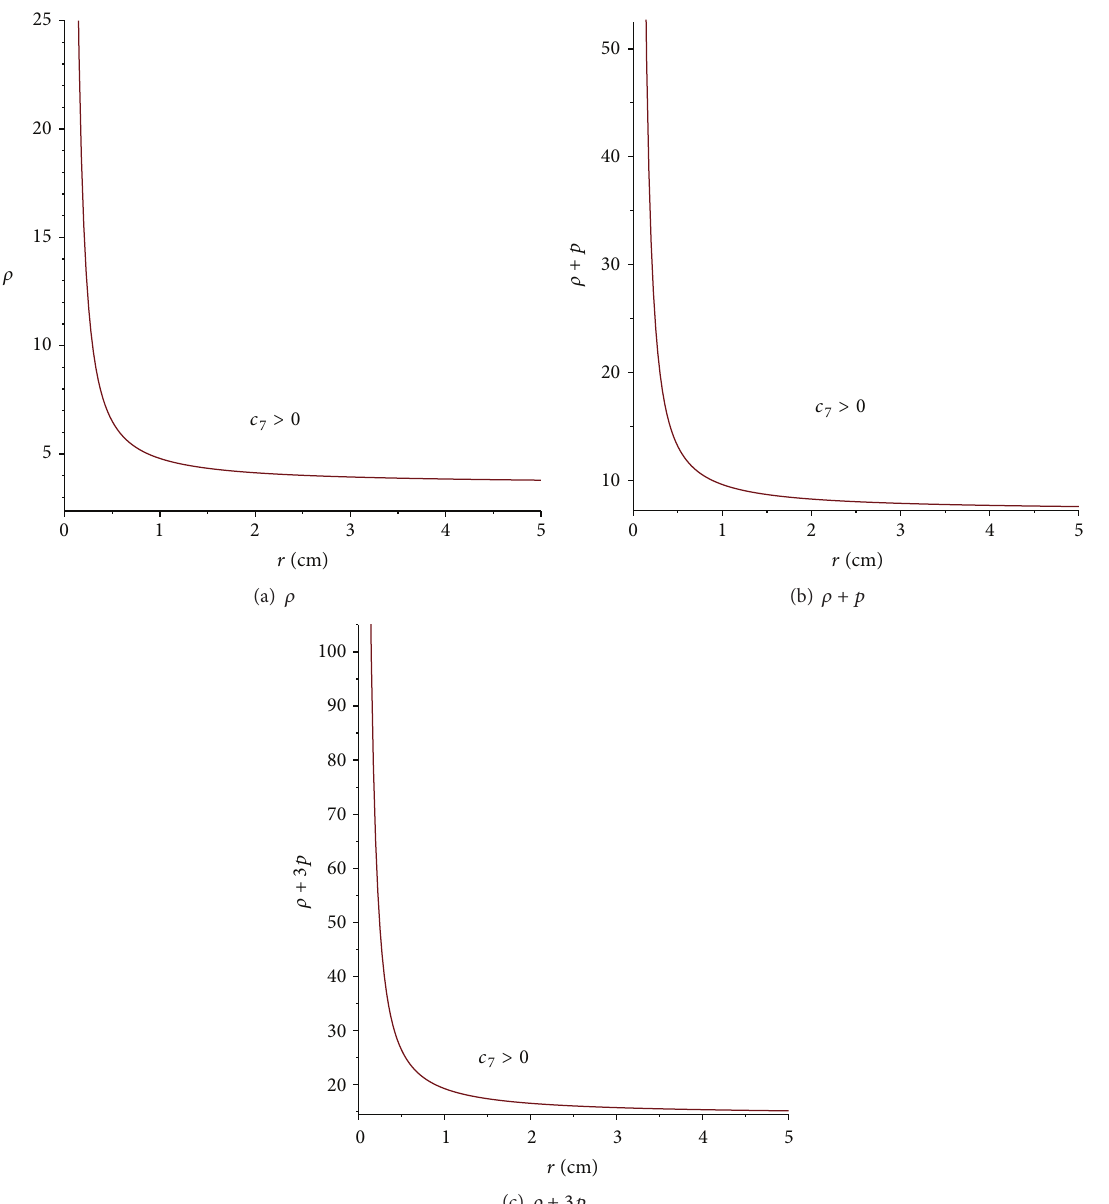
Figure 2: Energy conditions of the second model: the constant 𝑐 7 assumes a positive value so that the density is positive and also the pressure.